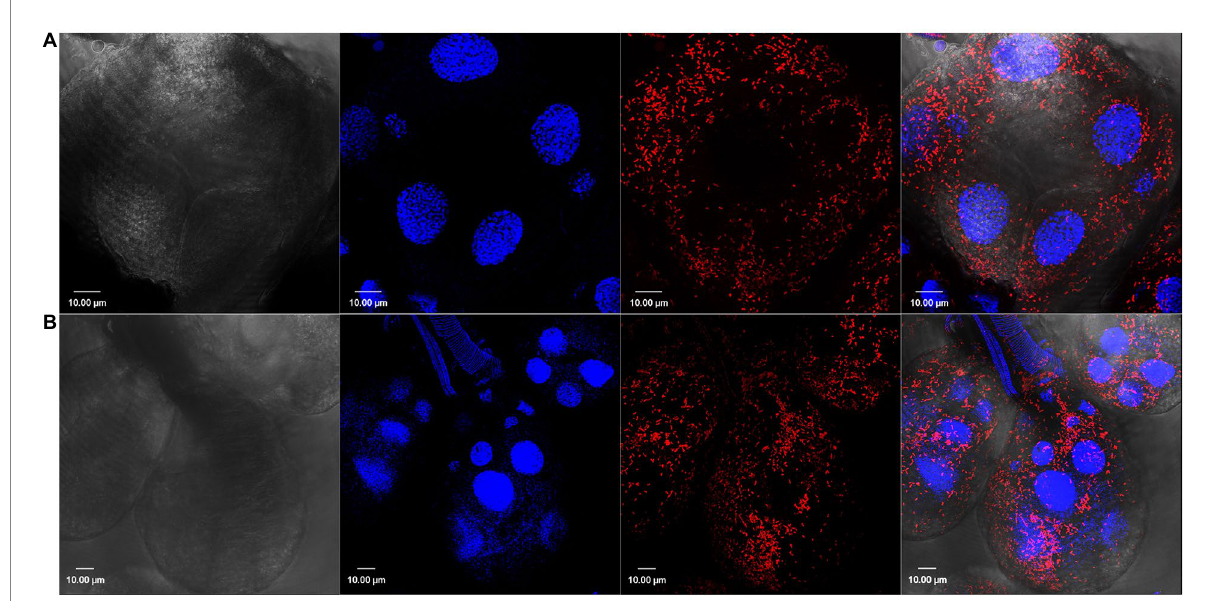
FIGURE 1 Confocal images showing tissue localization of Rickettsia parkeri in (A) unfed and (B) partially blood-fed Amblyomma maculatum salivary glands. Rod-shaped rickettsiae are localized intracellularly and depicted by their location in each salivary acini. DAPI (blue) was used to stain nuclei; Rickettsiae -specific antibody (M14-13) followed by Alexa-Fluor 568 conjugated anti-mouse IgG (red) was used to stain R . parkeri and differential interference contrast was used to capture tissue outline. Scale bar = 10 μ